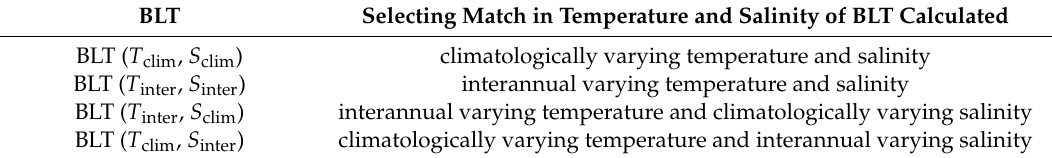
Table 1. Calculation of the interannual variation of barrier layer thickness (BLT) from the temperature field and salinity field, considering that the interannual variation of BLT is a ff ected by the interannual variation of temperature and / or